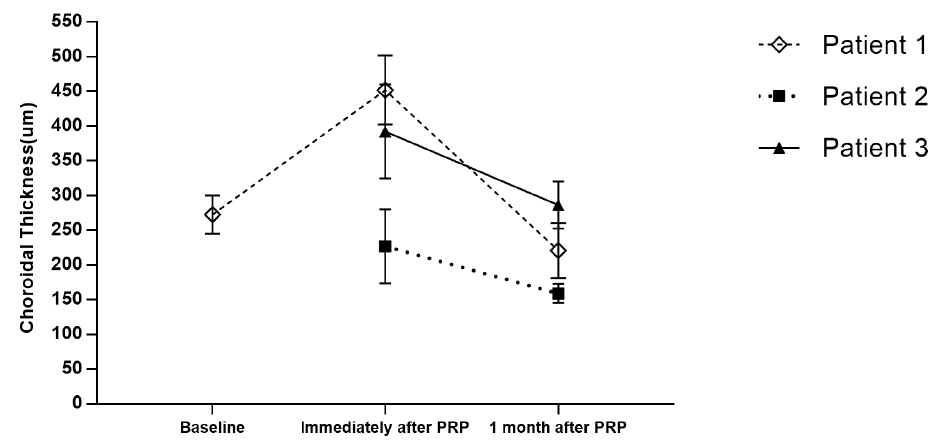
Figure 1. Change in choroidal thickness in patients prior and post PRP treatment.